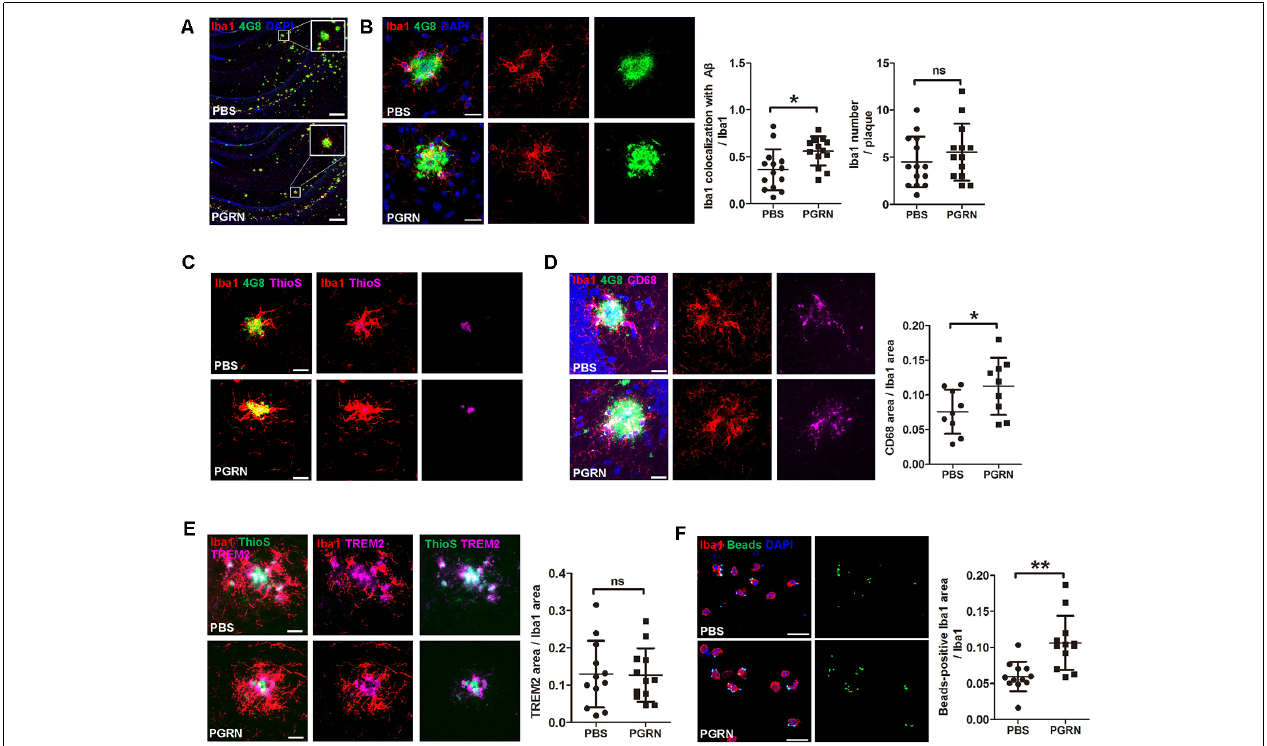
FIGURE 4 | PGRN enhances microglial phagocytosis. (A) Representative images of microglia with A β in the hippocampus of 5xFAD mice injected with PBS (control) or PGRN. microglia (Iba1, red), A β (4G8, green), and DAPI (blue). Scale bars, 200 µ m. (B) Representative images and quantification of colocalization of microglia with A β . microglia (Iba1, red), A β (4G8, green), and DAPI (blue). Scale bars, 20 µ m, n = 14 from three mice, * p < 0.05, unpaired student’s t -test. (C) Representative images of microglia with A β . A β (4G8, green), A β (ThioS, purple), and microglia (Iba1, red). Scale bars, 20 µ m. (D) Representative images of microglia with A β and quantification of CD68-positive Iba1 area. A β (4G8, green), microglia (Iba1, red), microglia (CD68, purple), and DAPI (blue). Scale bars, 20 µ m. n = 9 from three mice, * p < 0.05, unpaired student’s t -test. (E) Representative images of microglia with A β and quantification of the TREM2-positive Iba1 area. A β (ThioS, green), microglia (Iba1, red), and TREM2 (purple). Scale bars, 20 µ m, n = 12 from three mice, * p < 0.05, unpaired student’s t -test. (F) Representative images and quantification of fluorescent beads phagocytosis assay using isolated microglia from adult 5xFAD mouse brain and treated with PBS (control) or 500 ng/ml PGRN. microglia (Iba1, red), beads (green), and DAPI (blue). Scale bars, 20 µ m, n = 12 fields of view from three independent experiments, ** p < 0.01, unpaired student’s t -test. ns, not